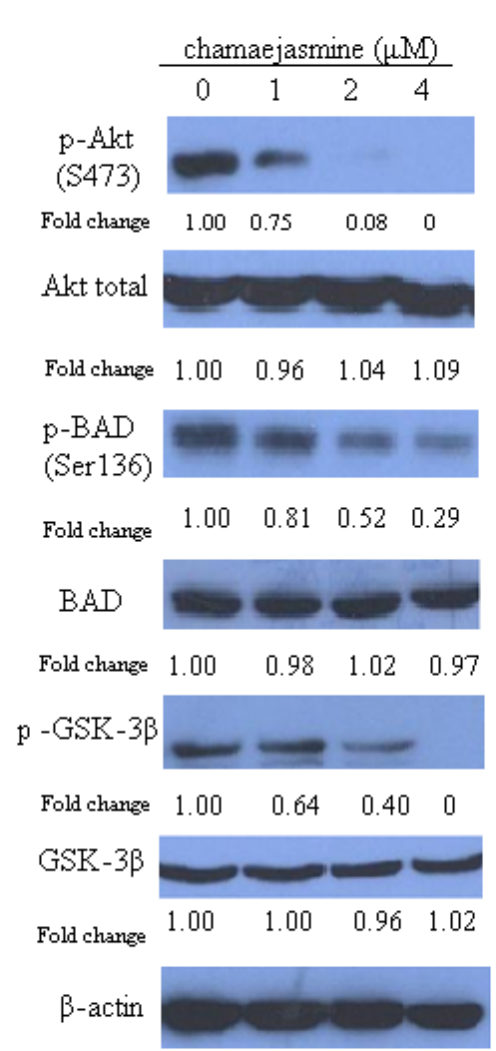
Figure 2. Immunoblotting for phosphor-Ser(473)-Akt, Akt, phospho-BAD, BAD, p-GSK-3 β and GSK-3 β using lysates from HEp-2 cells treated with chamejasmine (0, 1 µM, 2 µM and 4 µM) for 48 h. The blots were stripped and reprobed with anti- β -actin antibody to normalize the protein loading. Bands were quantitated by densitometric analysis. Fold change represents the protein level of the chamejasmine-treated cells relative to the control cells treated with vehicle and the resulting protein levels were then normalized to the β -actin